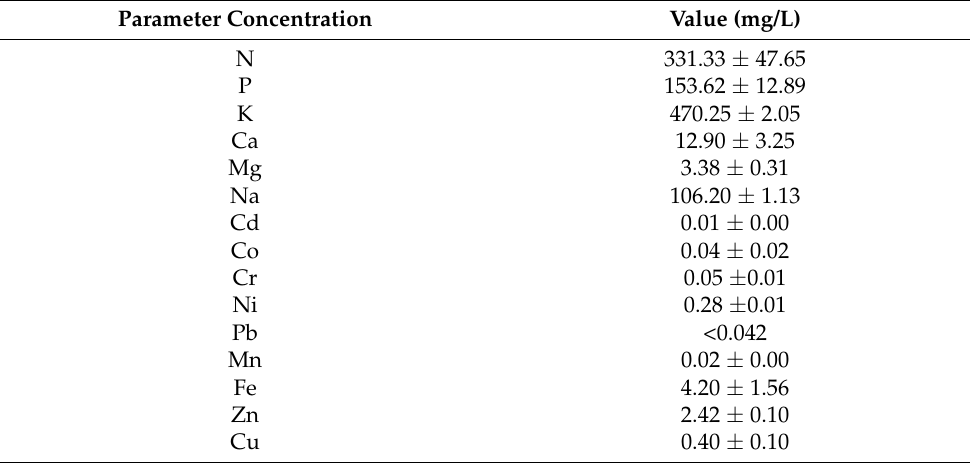
Table 1. Nutrient composition of the liquid digestate used in the experiment.